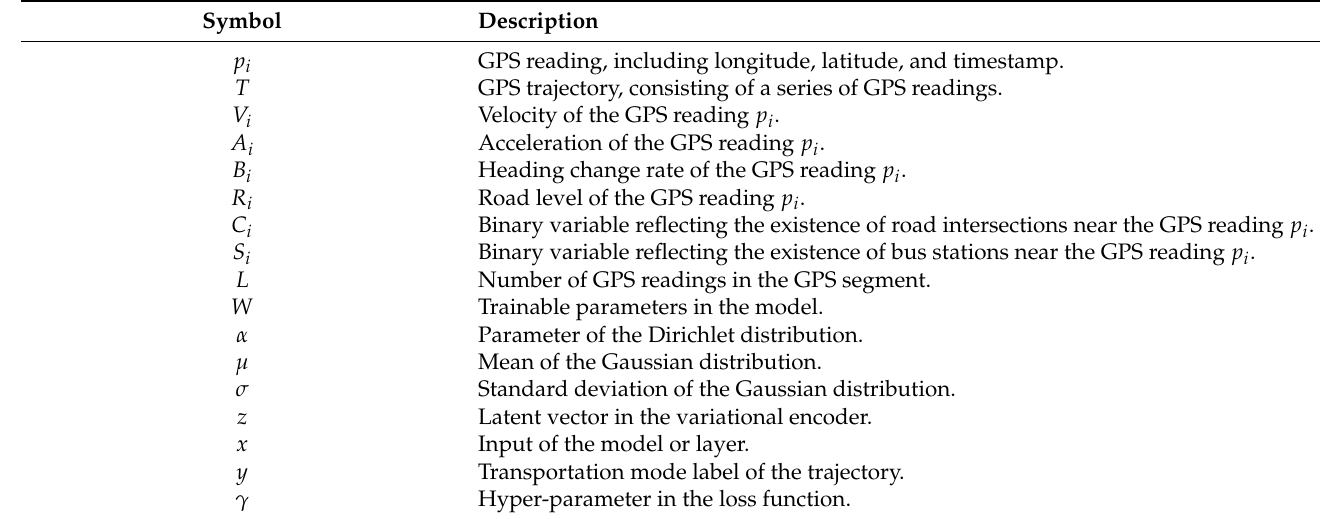
Table 1. Notation